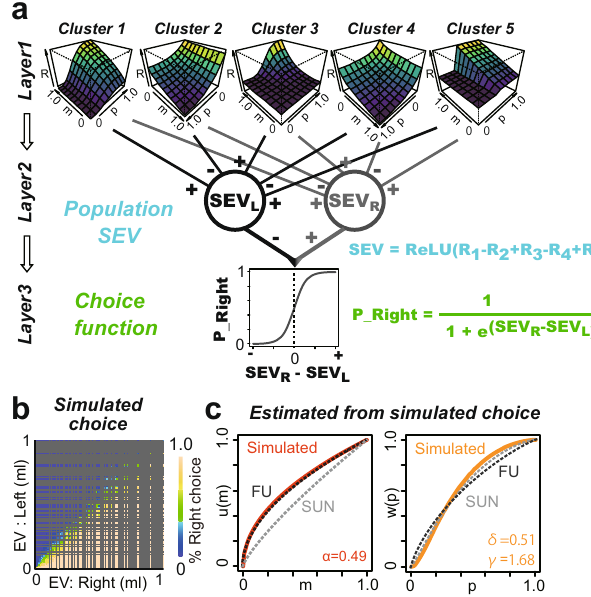
Fig. 6 | A simple network model reconstructs the subjective decision statistics inmonkeys.a FiveneuralclustersdetectedbyPCAintherewardcircuitry.Todraw the 3Dcurvature, R wasnormalizedto the maximalvalue. The subjective expected value functions (SEV) for the left and right target options are de fi ned as the linear summation of the fi ve clusters (see Methods). The choice was simulated as a sig- moid function of the SEV ’ s signal difference. b Frequencywith whichthe target on the right side was selected by a computer simulation based on the network shown in a . c u(m) and w(p) estimatedfromthesimulatedchoicedatain b areplotted.The dottedlinesindicatetheactualfunctions u(m) and w(p) ofthemonkeys,asshownin Fig. 1e and f,